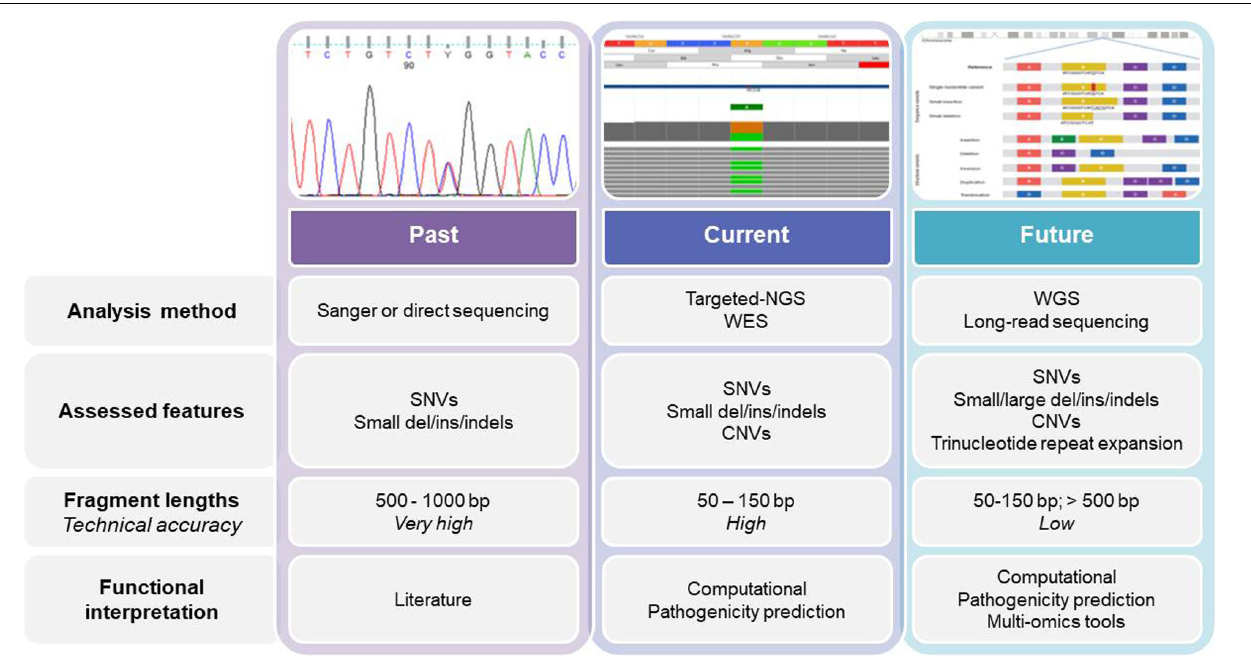
FIGURE 1 | The past, present, and future of genetics and genomics technologies for the diagnosis of and research into hereditary anemias. The diagram shows the current analysis methods for DNA sequencing, while also highlighting the main differences among them. WES, whole-exome sequencing; WGS, whole-genome sequencing; SNV, single nucleotide variant; CNV, copy number variation.